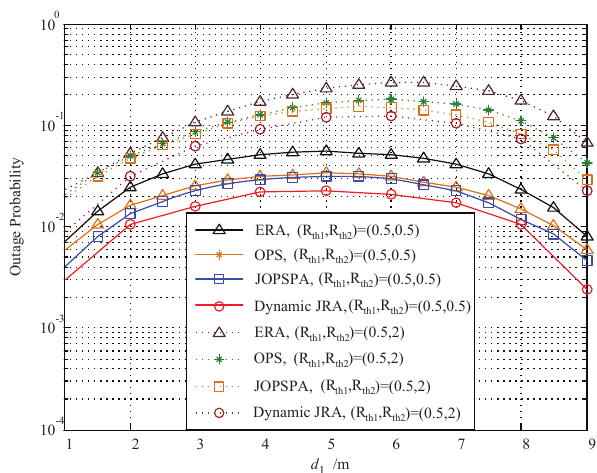
Figure 8. Outage probability vs. d 1 based on instantaneous